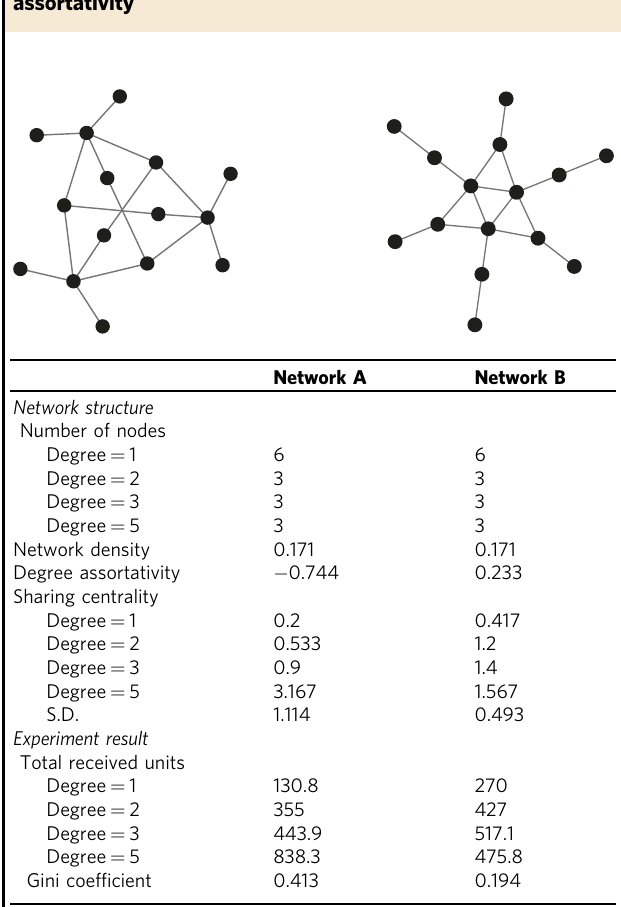
Table. 1 Economic inequality depending on degree